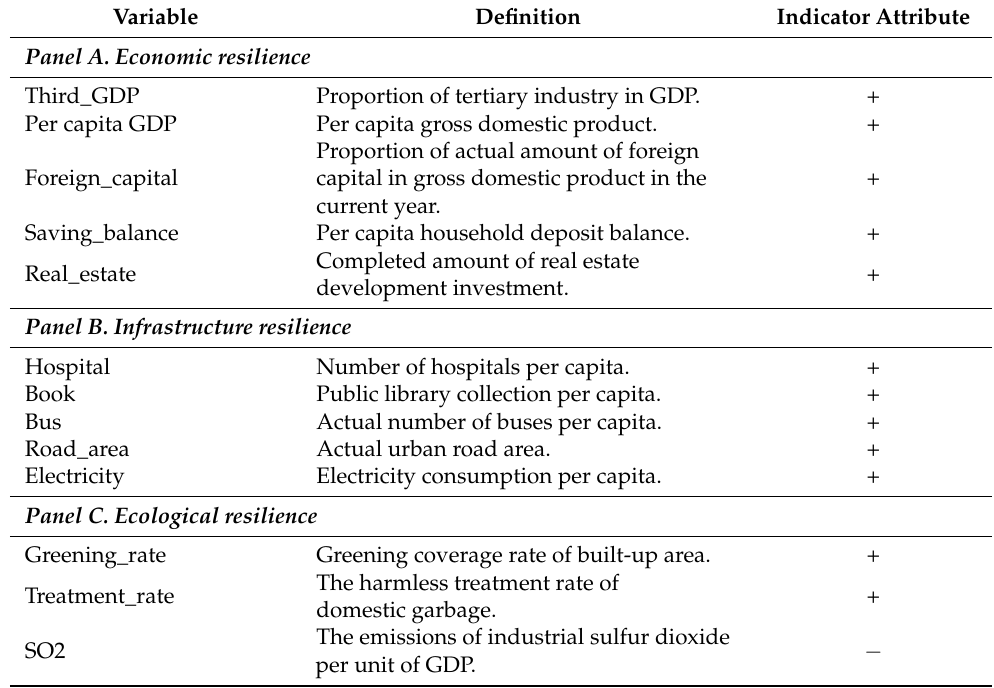
Table 1. Urban resilience indicators .